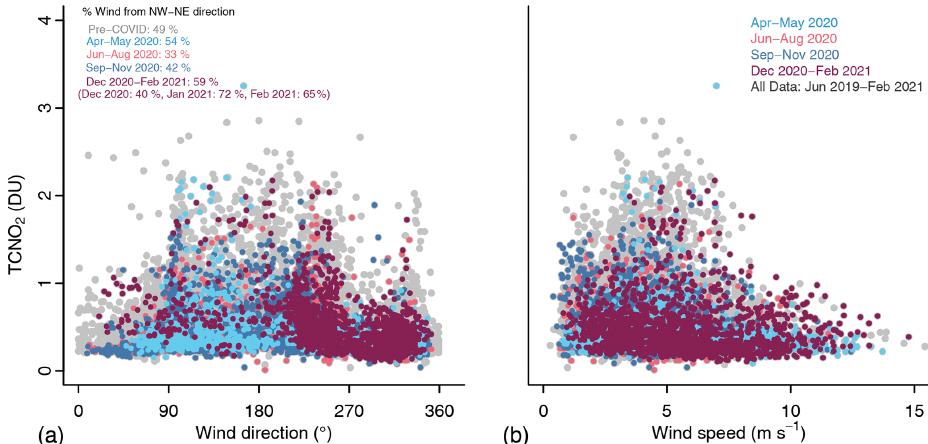
Figure 10. Relationship between column NO 2 amounts (DU, PSI #135 data, 15min averaged) and (a) wind direction (in degrees from north) and (b) wind speed (in ms − 1 ; ATMOS 41 data) organized by post-lockdown season, measured from June 2019 to February 2021 in Upper West Manhattan.